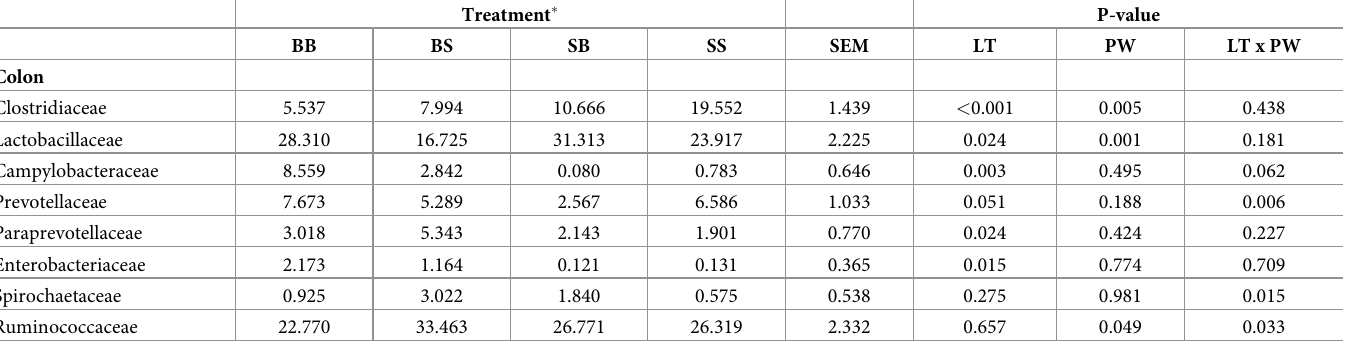
Table 8. Effect of supplementation of CH-YBG during gestation/lactation and/or post-weaning on differential relative abundance of bacterial taxa at the family level in pig colonic digesta on day 10 post-weaning. (least-square mean values with their standard error of means). Treatment �